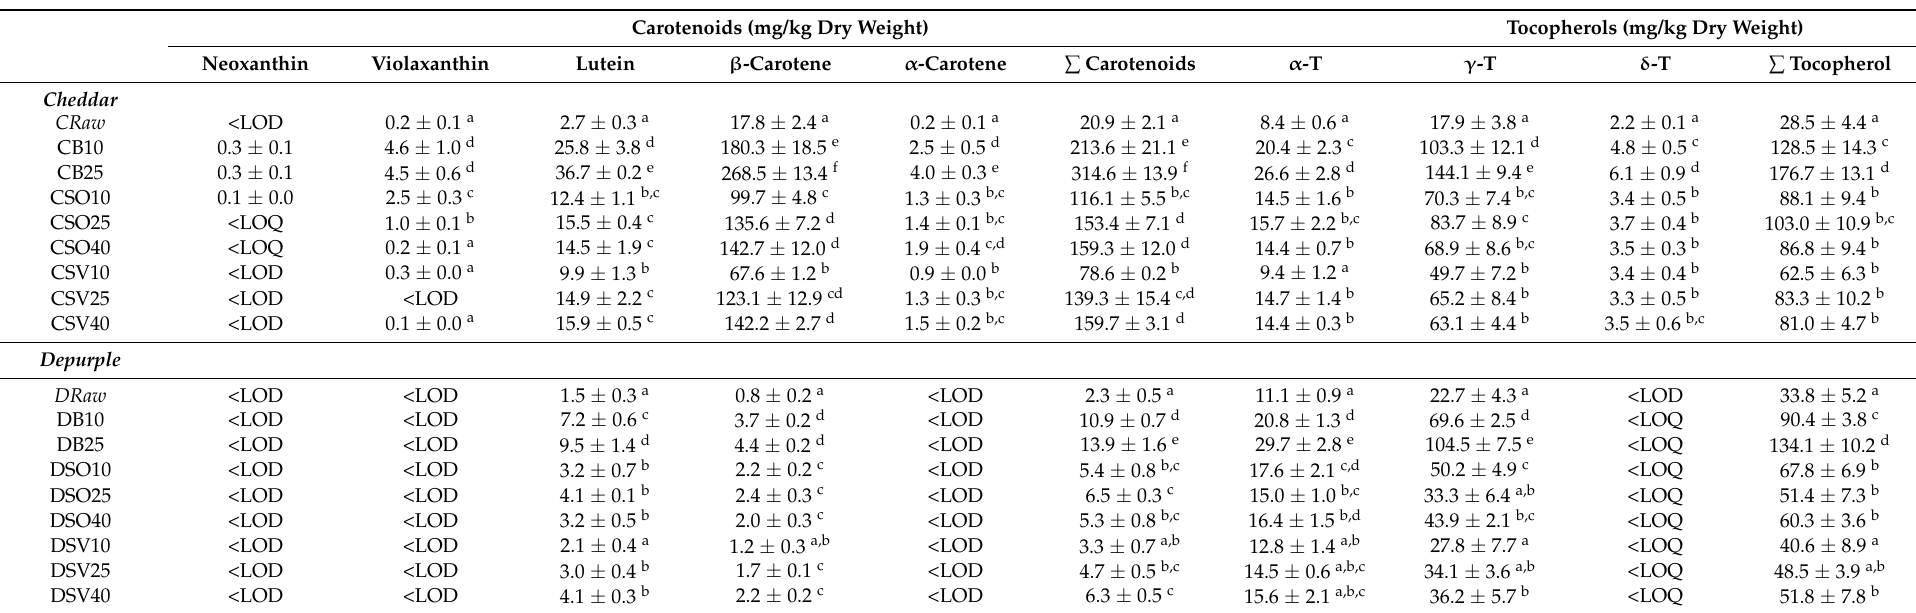
Table 2. Carotenoids and tocopherols content in raw, boiled (B), steam oven (SO) and sous-vide (SV)